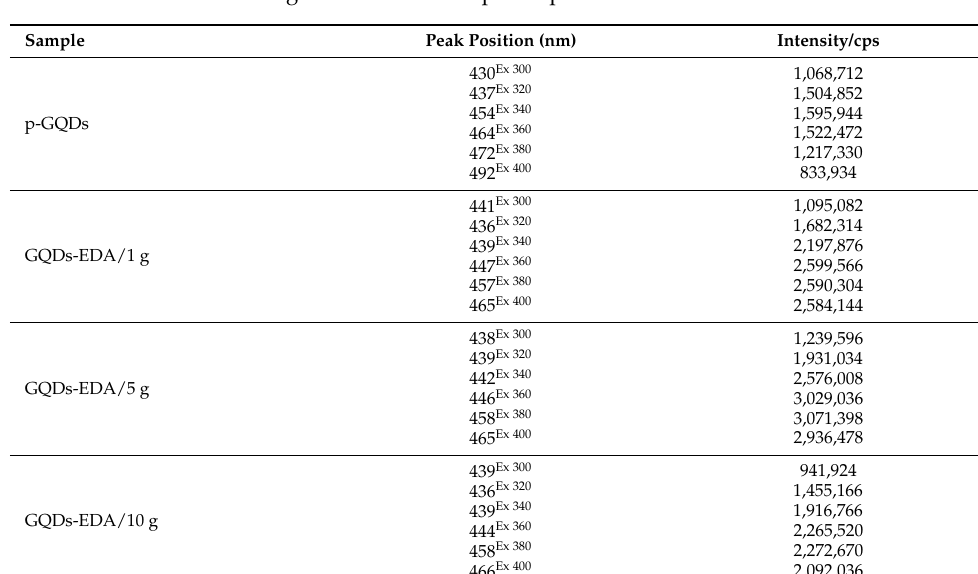
Figure 8. 3D PL spectra of p-GQDs ( a ), GQDs-EDA/1 g ( b ), GQDs-EDA/5 g ( c ), and GQDs-EDA/10 g ( d ) recorded at excitation wavelengths in the range of 300 – 340 nm. Table 2. Data obtained by recording emission spectra of p-GQDs and irradiated N-doped GQDs, at different excitation wavelengths indicated as superscript